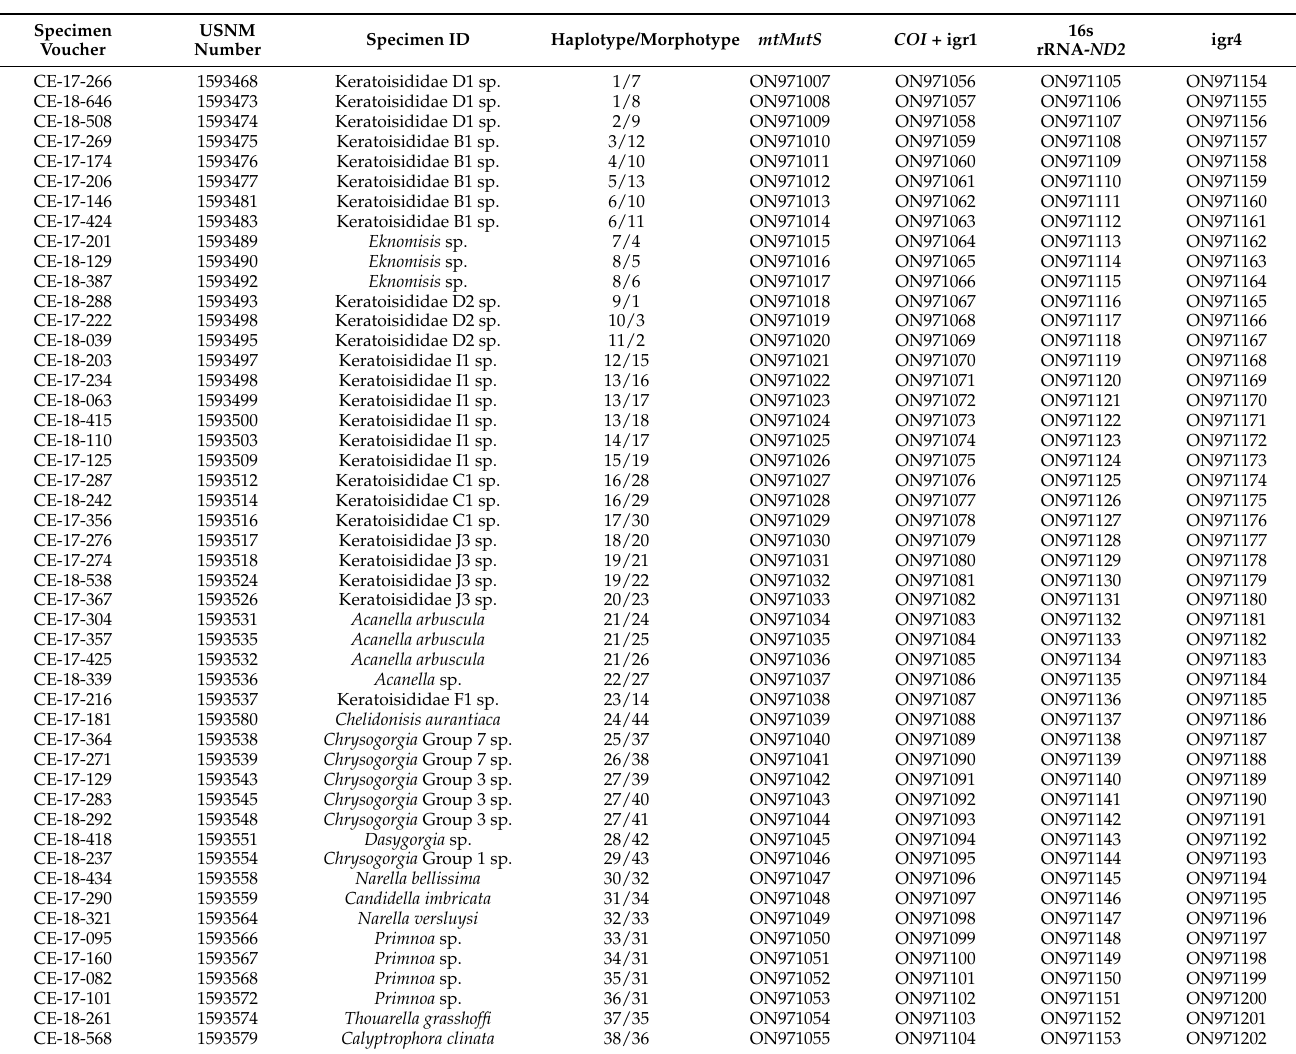
Table 2. GenBank Accession numbers for gene fragments sequences for every